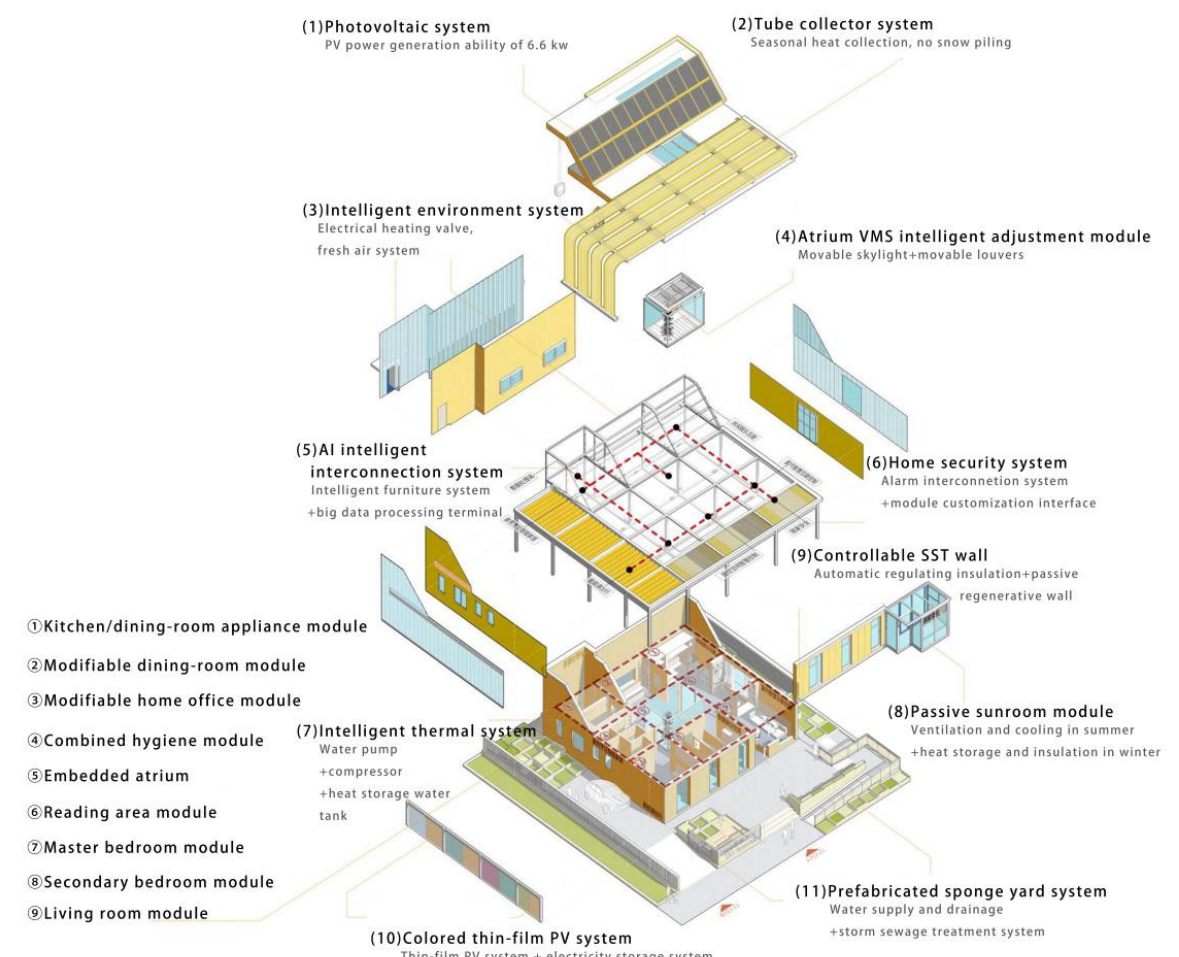
Figure 2. Integrated zero energy technology and intelligent control system of T&A House.